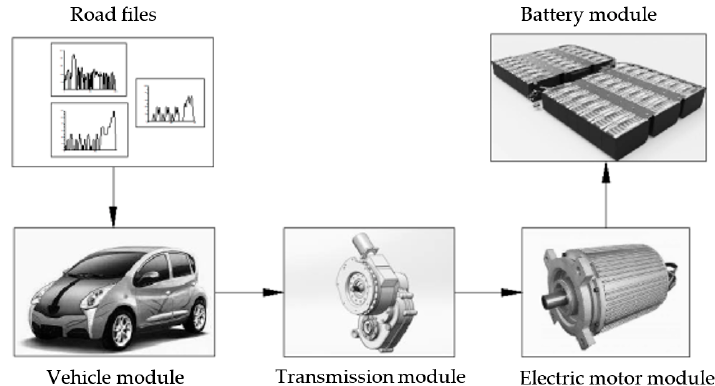
Figure 4. Drive chain mode.